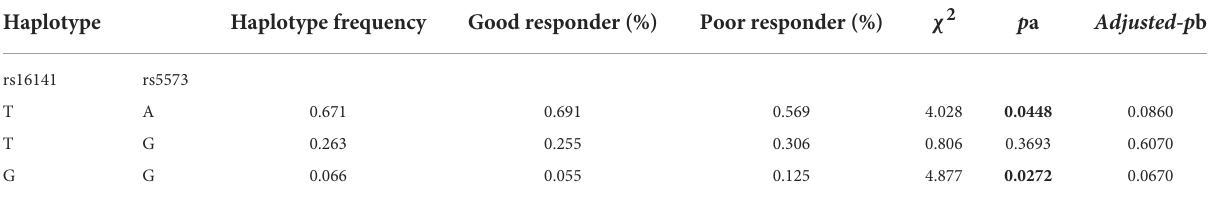
TABLE 5 Frequency distribution and association analysis of haplotypes of NPY gene with antipsychotics response. Haplotype